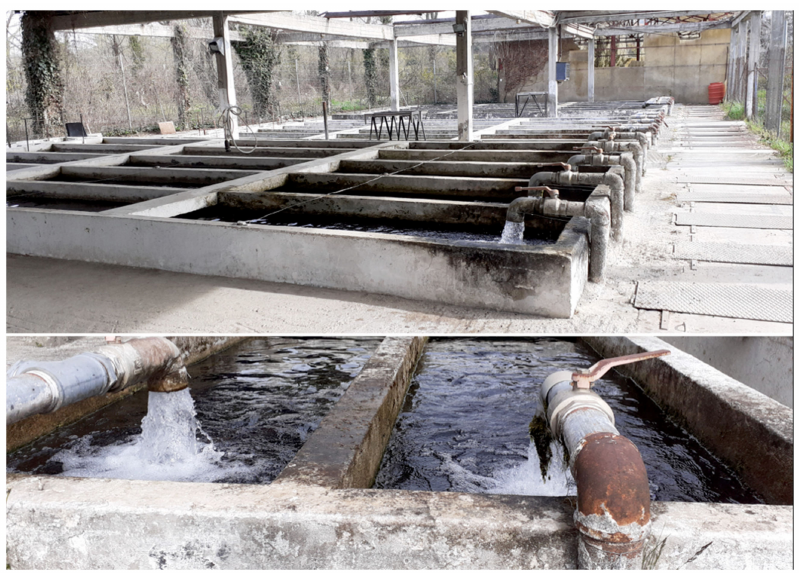
Figure 1. Concrete raceways built on the flow through of a small river in Pella, Greece, utilized in rainbow trout